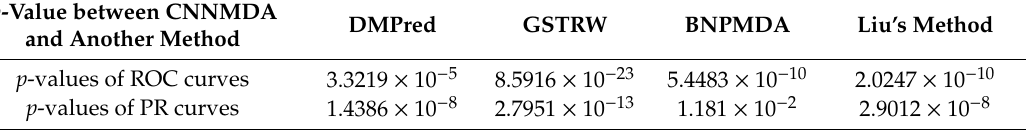
The bold values indicate the higher AUPRs. Table 3. Comparison of different methods based on AUCs with a paired t -test. Table 3. Comparison of di ff erent methods based on AUCs with a paired t -test. p -Value between CNNMDA and Another Method